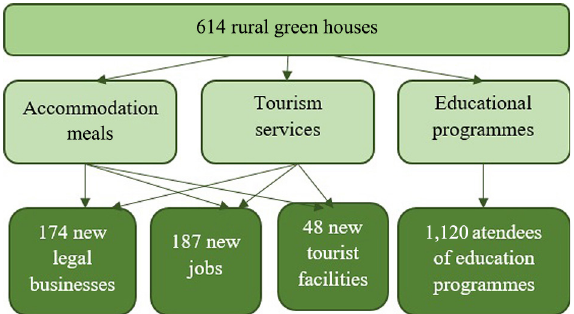
Fig. 2. Structure of activities in rural tourism in the Altai